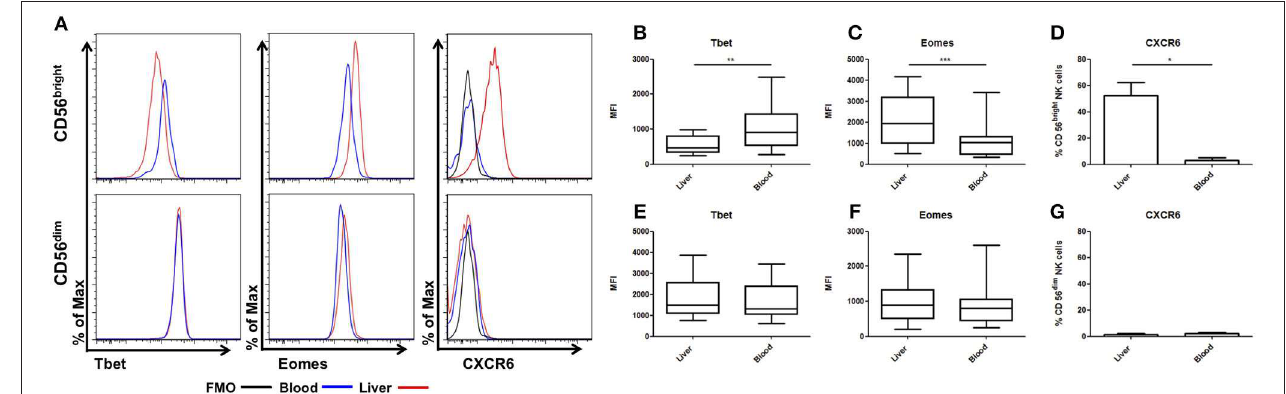
FIGURE 1 | CD56 bright NK cells have unique tissue resident phenotype. Mononuclear cells isolated from liver perfusate (LP) and matched peripheral blood (PB) were stained with monoclonal antibodies. NK cells were identified from the CD45 + lymphocyte gate as CD56 + CD3 − . CD56 bright CD16 − / + and CD56 dim CD16 + subsets were then gated and non-viable cells were excluded by FVS780 staining. (A) Representative histograms of Tbet, Eomes and CXCR6 expression in LP and PB NK cell subsets. (B) The MFI of Tbet in CD56 bright NK cells. (C) The MFI of Eomes in CD56 bright NK cells. (D) Percentage of CXCR6 positive CD56 bright NK cells. (E) The MFI of Tbet in CD56 dim NK cells. (F) The MFI of Eomes in CD56 dim NK cells. (G) Percentage of CXCR6 positive CD56 dim NK cells. Data presented as mean ± SEM (D,G) or box and whisker plots with minimum and maximum values (B,C,E,F) . Data was analyzed using Wilcoxon matched pairs test ( n = 10; * p < 0.05, ** p < 0.01, and *** p < 0.001).